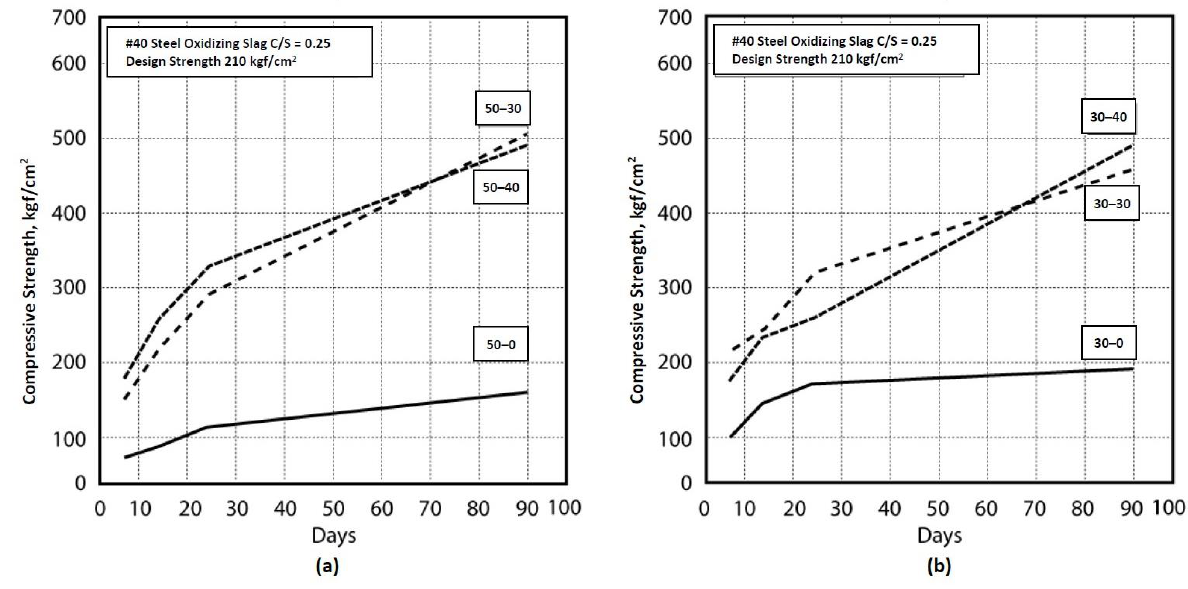
Figure 6. Compressive combination strengths on the 0.25 ratio. ( a ) EAF oxidizing slag adjunction with a percentage of 50%. ( b ) EAF oxidizing slag adjunction with a percentage of 30%.